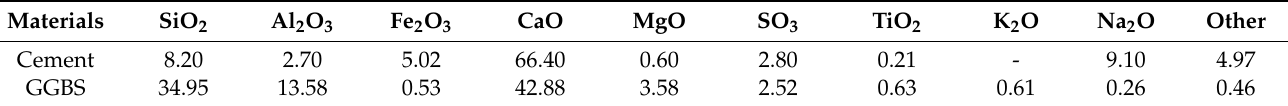
Table 1. Chemical composition of cement and GGBS.